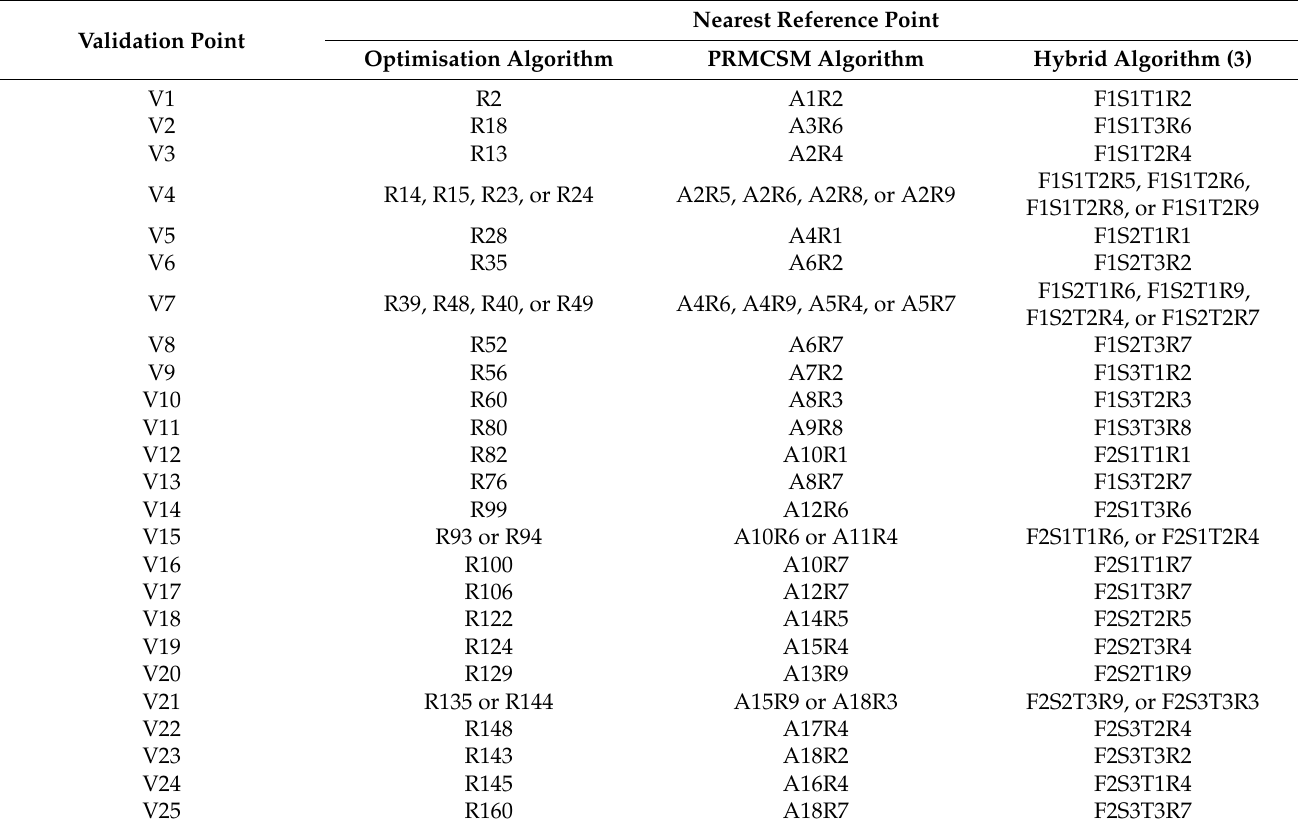
Table A1. Nearest reference points of all validation cases obtained by different algorithms. Validation